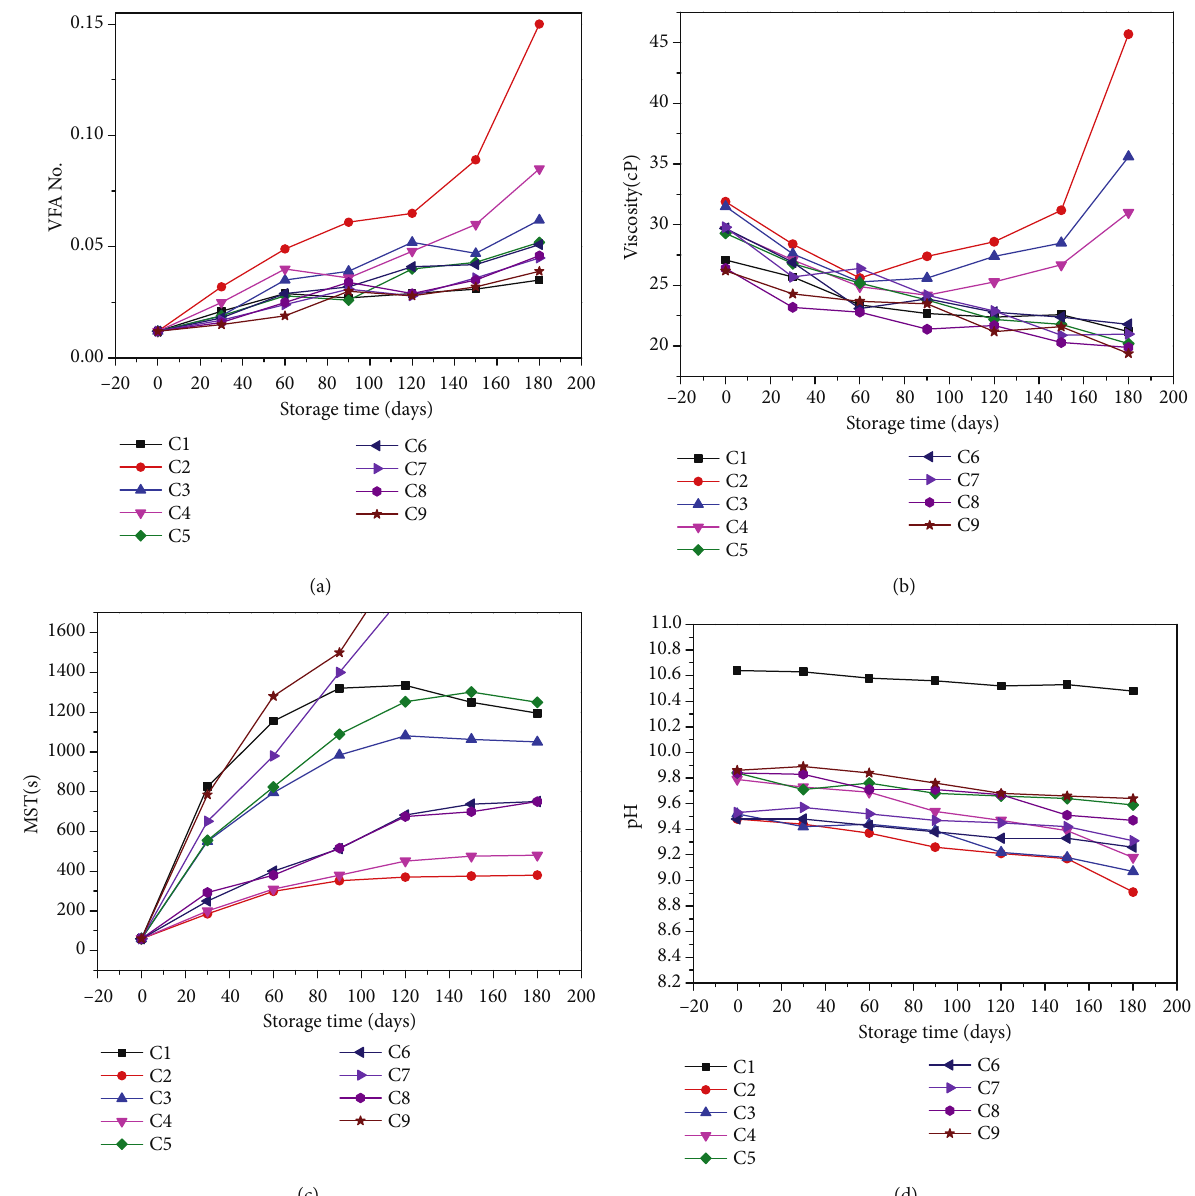
Figure 3: Properties versus the storage time of LA-CNRL: (a) VFA No.; (b) viscosity; (c) MST; and (d)